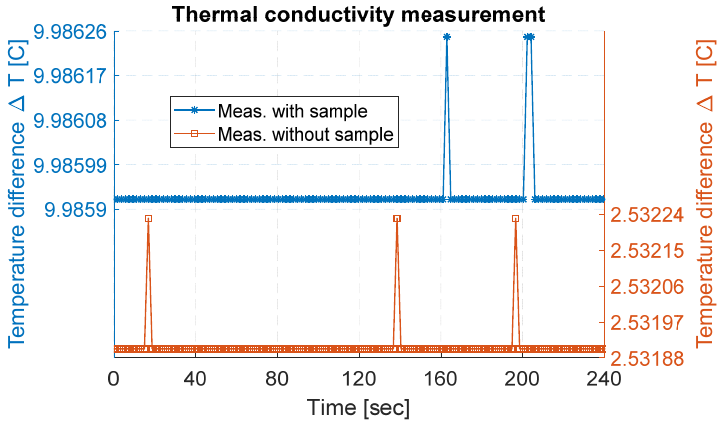
Figure 4. Thermal conductivity measurement data plotted for a few minutes. On the right y-axis, measurement data without a sample are plotted, while on the left y-axis, measurement data with a sample are plotted.